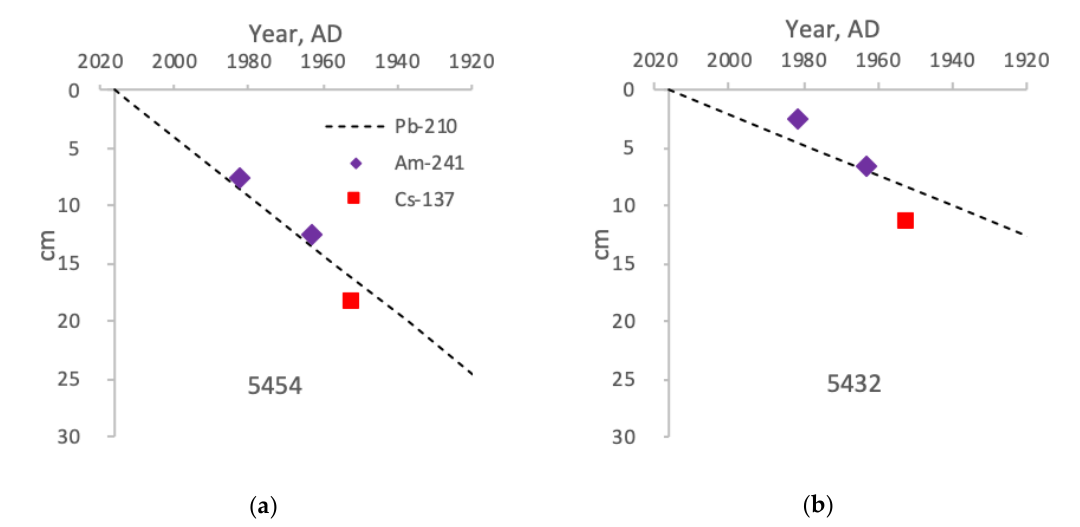
Figure 19. An age model constructed using excess lead-210 and its correspondence to chronostratigraphic markers 241 Am and 137 Cs for the sediment cores AMK-5454 ( a ), the Cambridge Strait, and AMK-5432 ( b ), the Bear Island Trough.